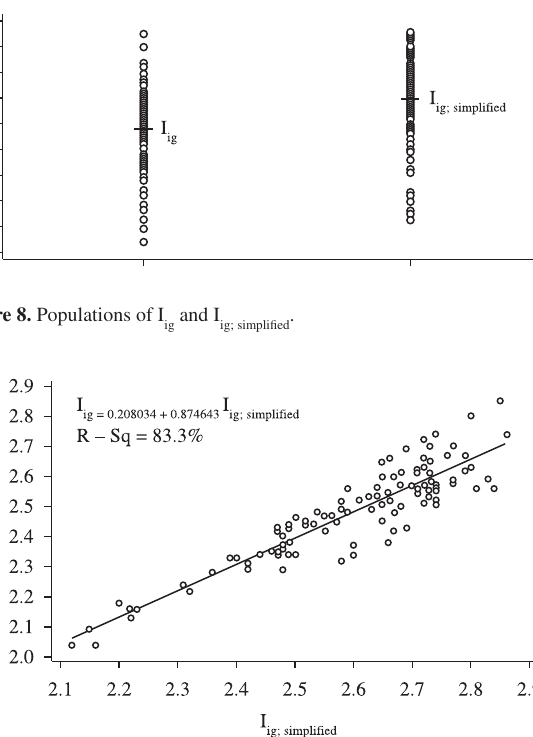
× I . ig ig; simplified